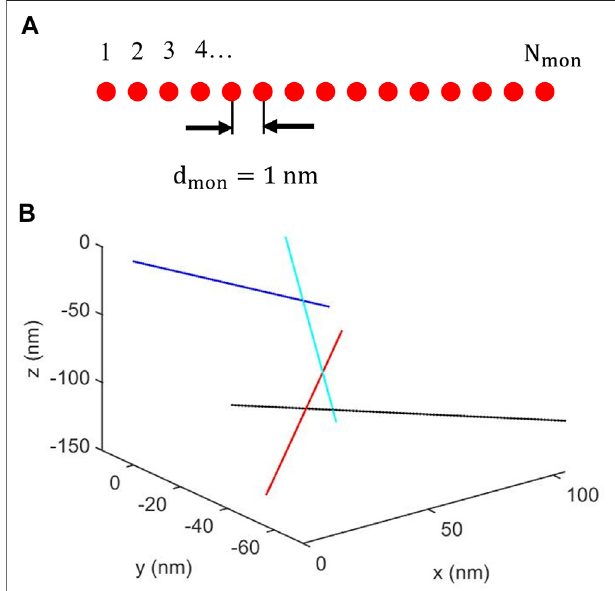
FIGURE2|(A) Schematicillustrationofa fi brilcomposedofalineararray of N mon identical monomers equally spaced with a separation d mon . (B) Example of cluster of four fi brils. For clarity, the fi brils are represented with different colors. Fibril #1 (blue) shares a monomer position with fi bril #2 (cyan) . Fibril #2 also shares a monomer position with fi bril #3 (black) , that in addition shares a monomer position with fi bril #4 (red)